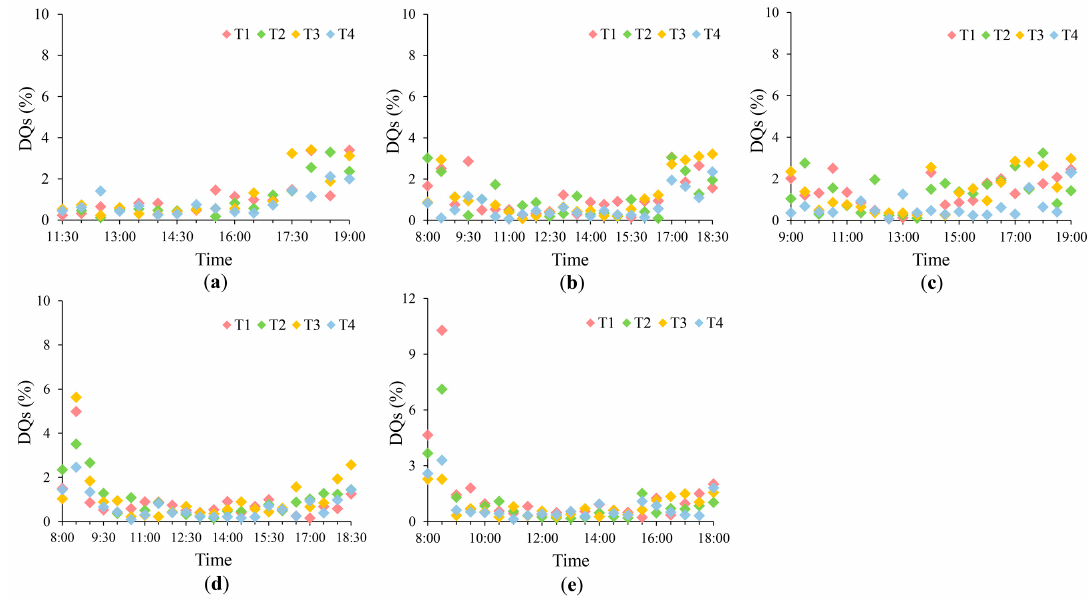
Figure 8 . DQ s values of the measurements: ( a ) 10 July; ( b ) 17 July; ( c ) 18 July; ( d ) 21 August; and ( e ) 22 August. T1 to T4 represent the measurements of the four canopy targets.